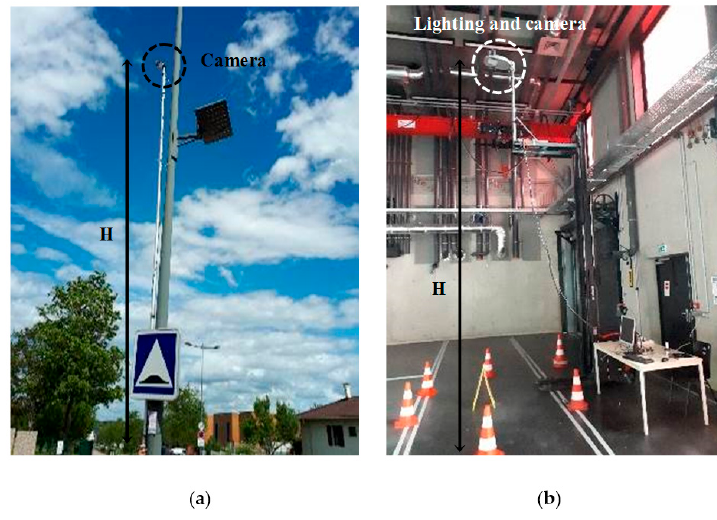
Figure 3. Diurnal ( a ) and nocturnal ( b ) test bench.